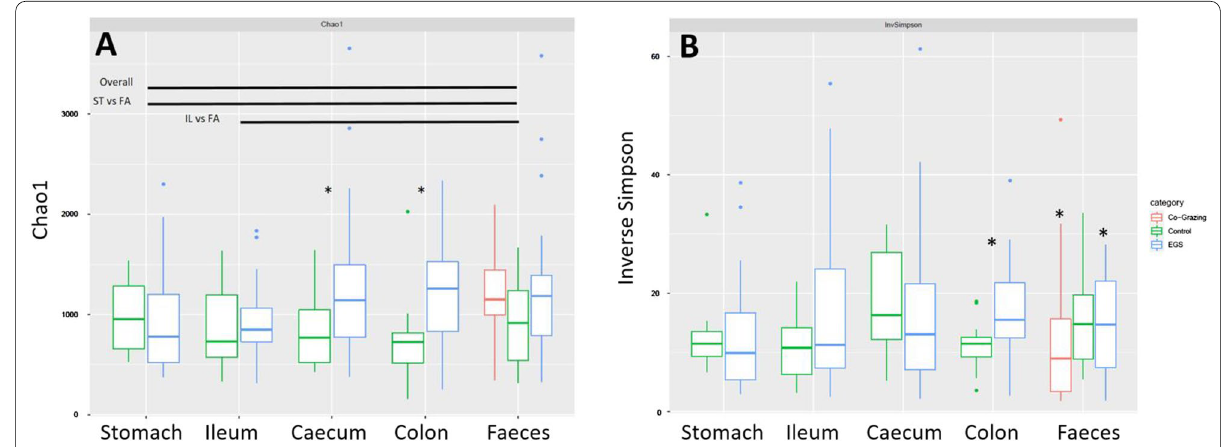
Fig. 2 Box plots showing alpha-diversity of mycobiota in different GI sites for EGS, CTRL and CoG horses, estimated as A Chao1 and B Inverse Simpson indices. Inter-site significant differences are identified as bars, while inter-group significant differences are indicated by asterisks. For